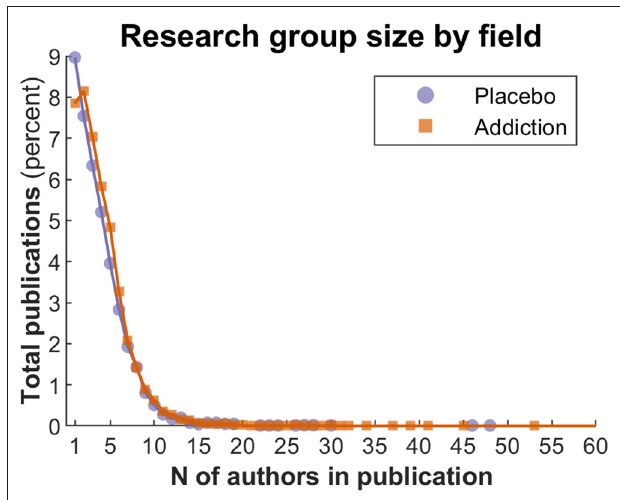
FIGURE 10 | Research group size by